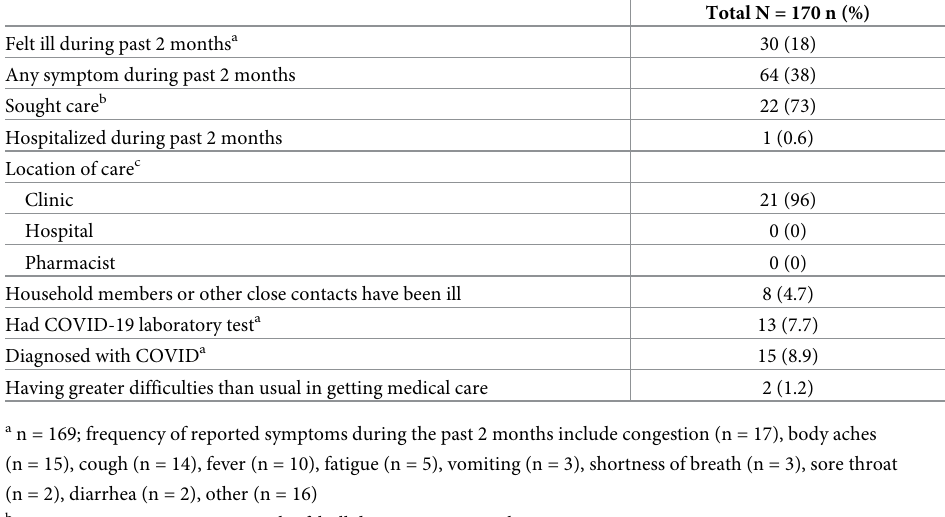
Table 5. Health status and health-seeking behavior among late postpartum WHIV during the COVID-19